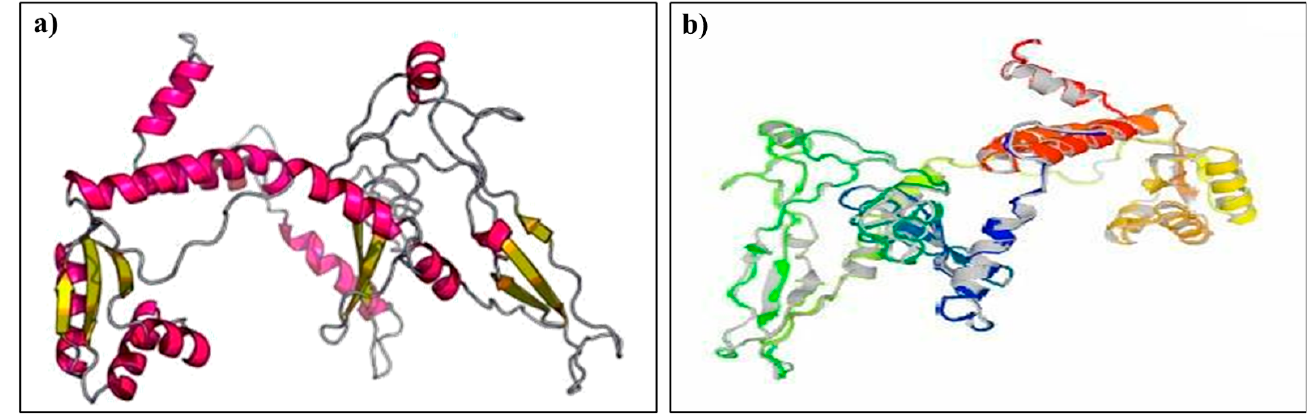
Figure 2. Prediction and refinement of the tertiary structure of the candidate vaccine. ( a ) The 3D model of the designed multi-epitope vaccine. ( b ) Galaxy-refined structure of the vaccine model.